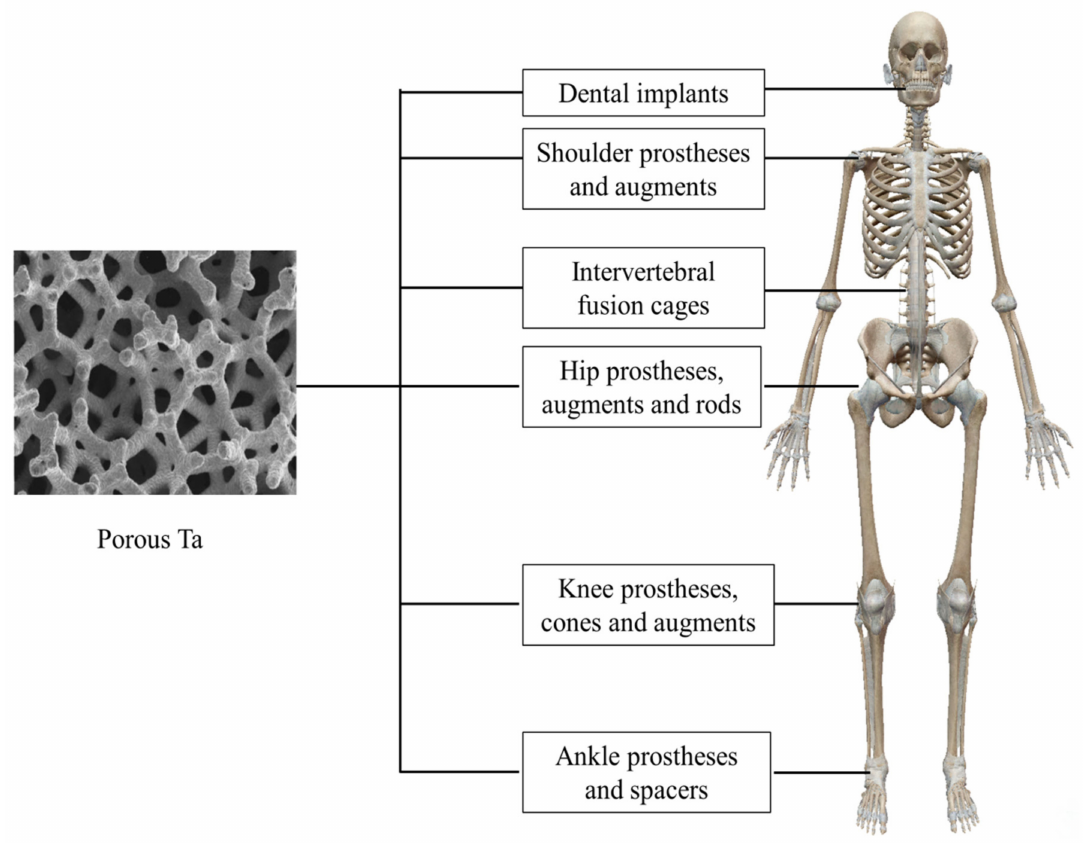
Figure 3. Application of porous Ta in different parts of the human